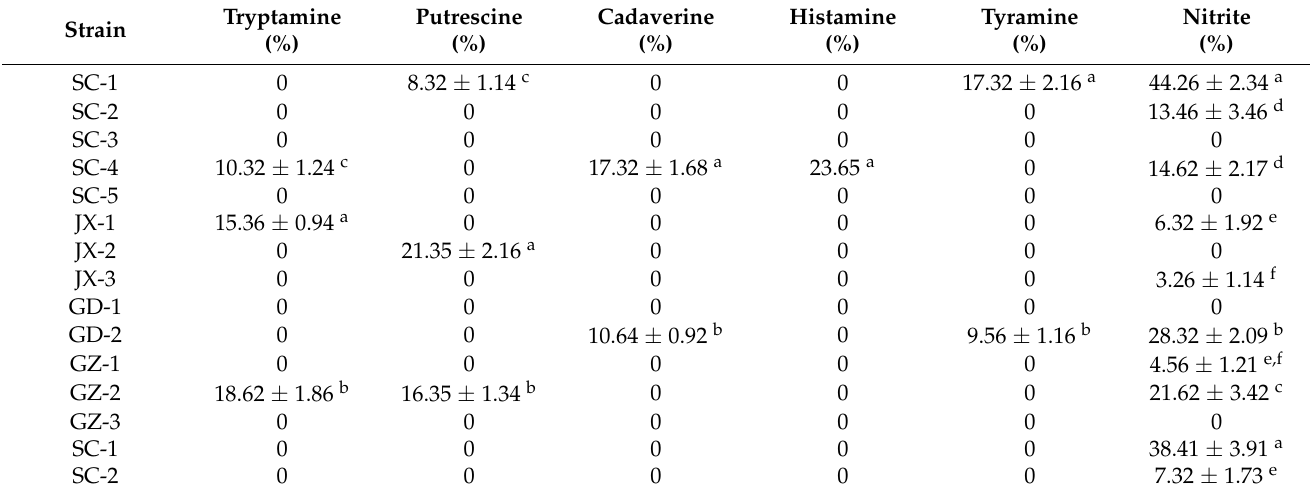
Table 6. The BA-degradation abilities of the isolated strains with corresponding precursor. Different letters (a, b, c, etc.) indicate significantly different means at p < 0.05.